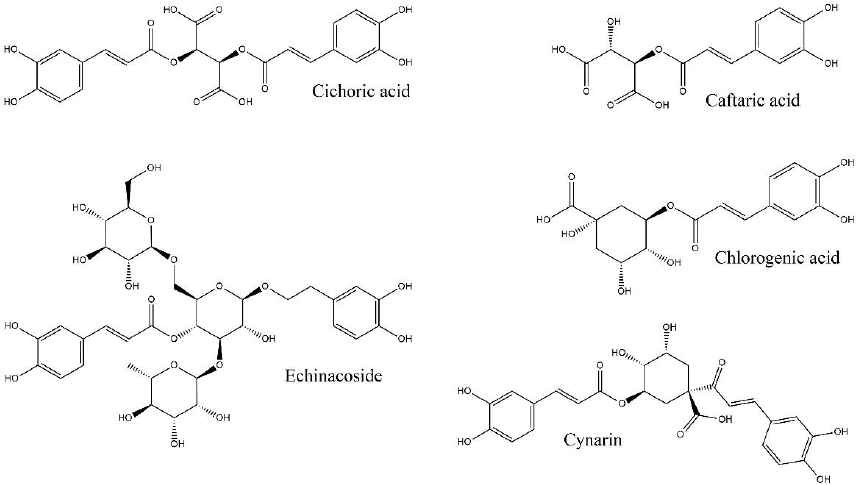
Figure 3. Chemical structures of caffeic acid derivatives (CADs) present in Echinacea purpurea (orig-